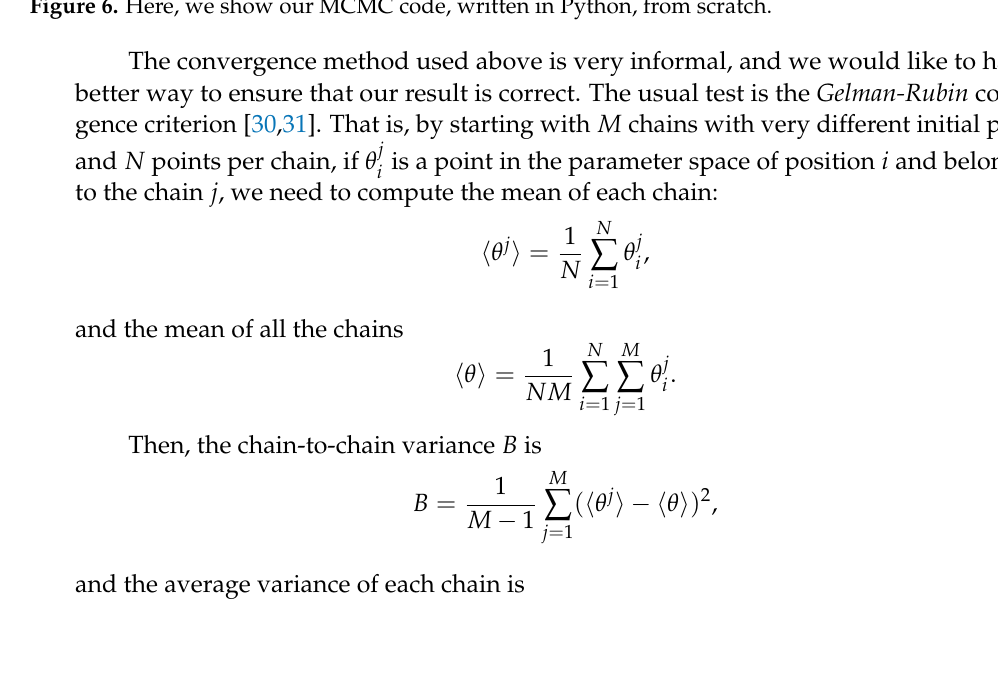
Figure 6. Here, we show our MCMC code, written in Python, from